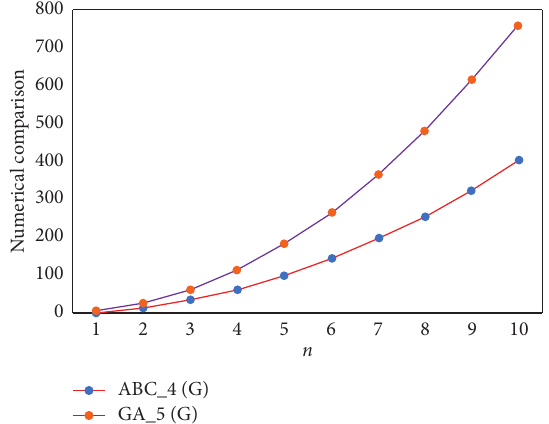
Figure 8: Comparison of ABC